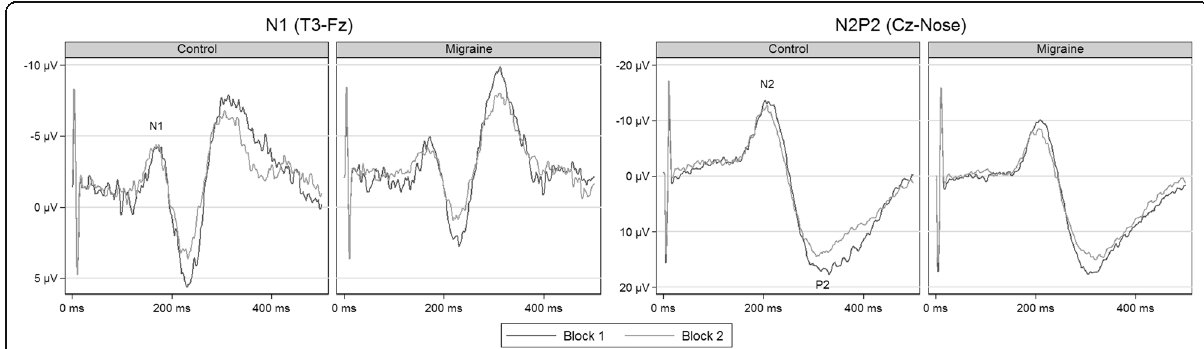
Fig. 2 Grand average of the LEP-traces in first session interictal recordings and controls. N2P2-habituation was present in both groups, but we found no significant N1-habituation. The amplitudes in the figures are smaller than those presented in Table 4 due to slightly different LEP-latencies between